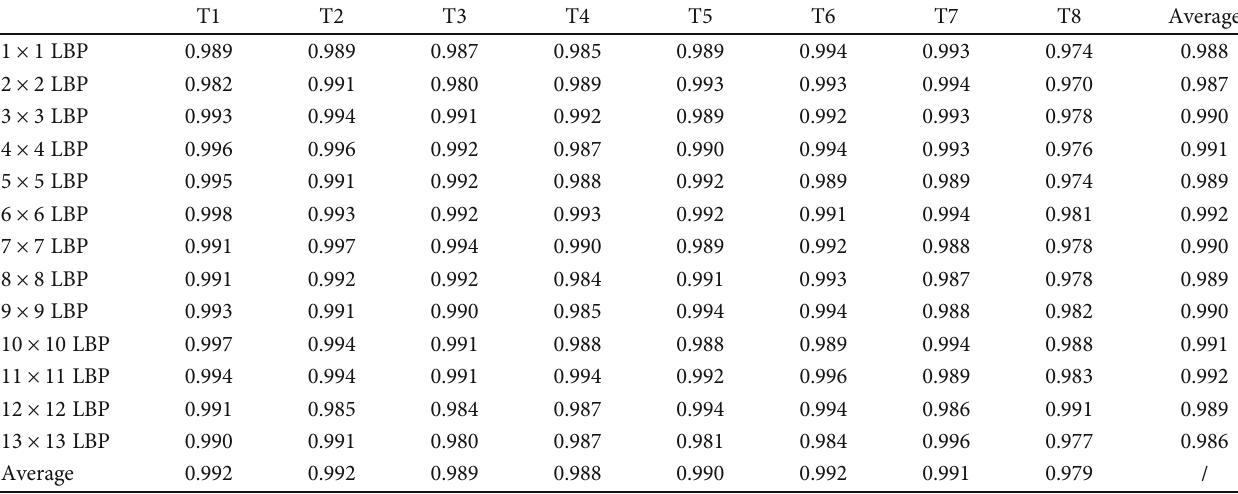
Table 4: Average classi fi cation accuracy of fusion features in 5 times 10-fold cross validation.